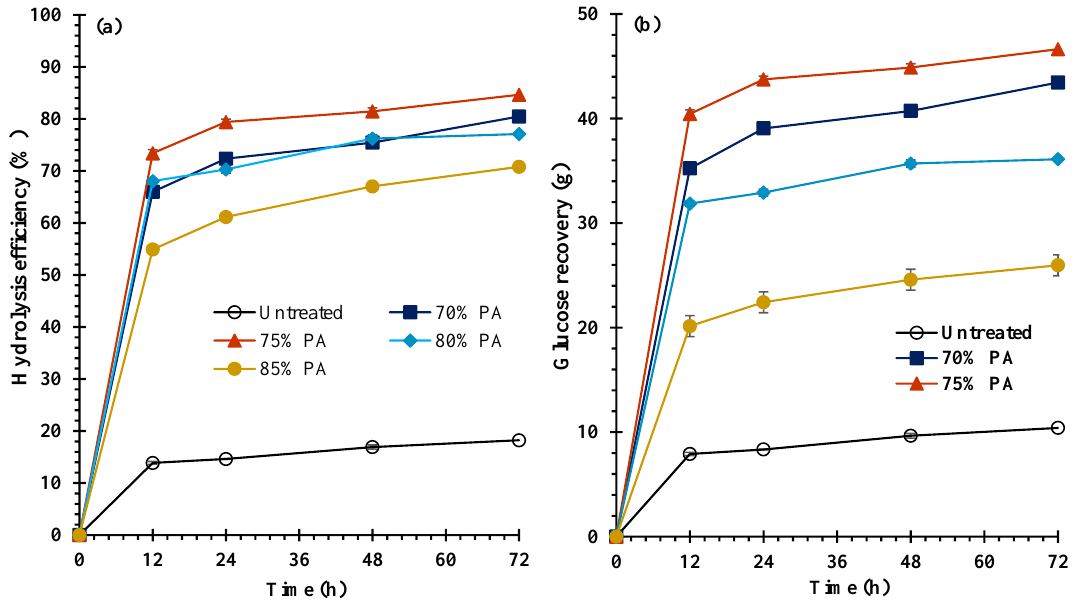
Figure 2. ( a ) Hydrolysis efficiency (HE) and ( b ) Glucose recovery (GR) of bark fiber.